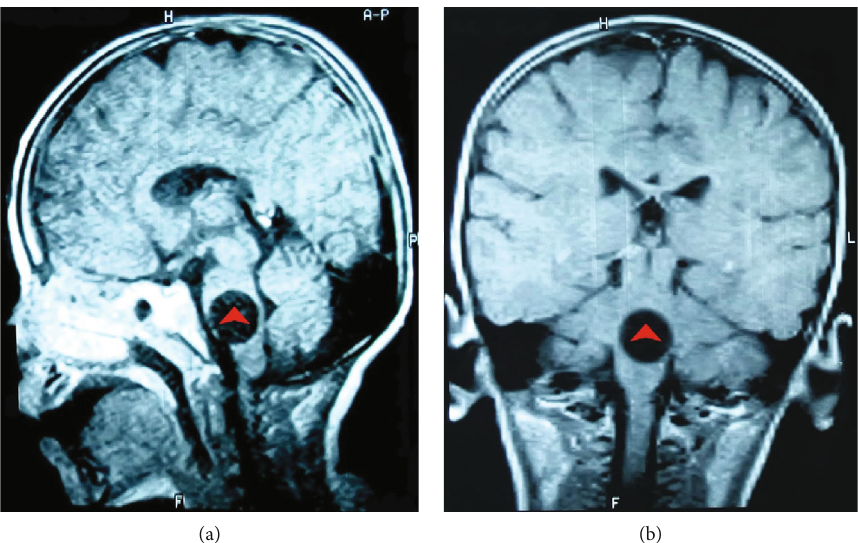
Figure 1: Noncontrast T1-weighted MRI shows round, well-circumscribed, isointense cyst (red arrowheads). (a) Sagittal image. (b) Coronal image.